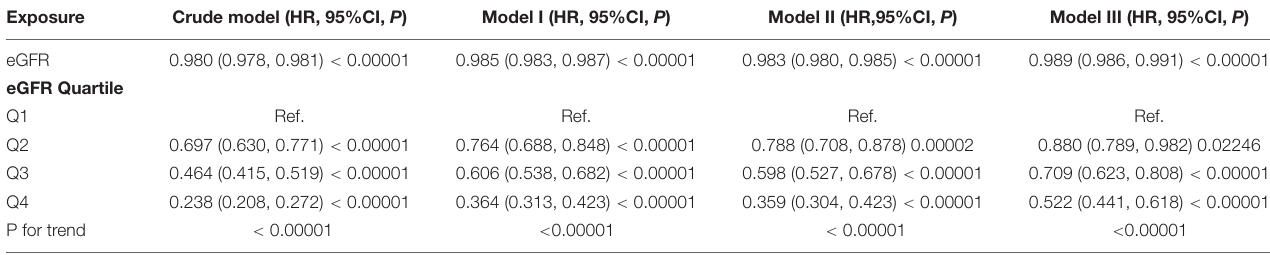
TABLE 4 | Relationship between eGFR and the incident NAFLD in different models.